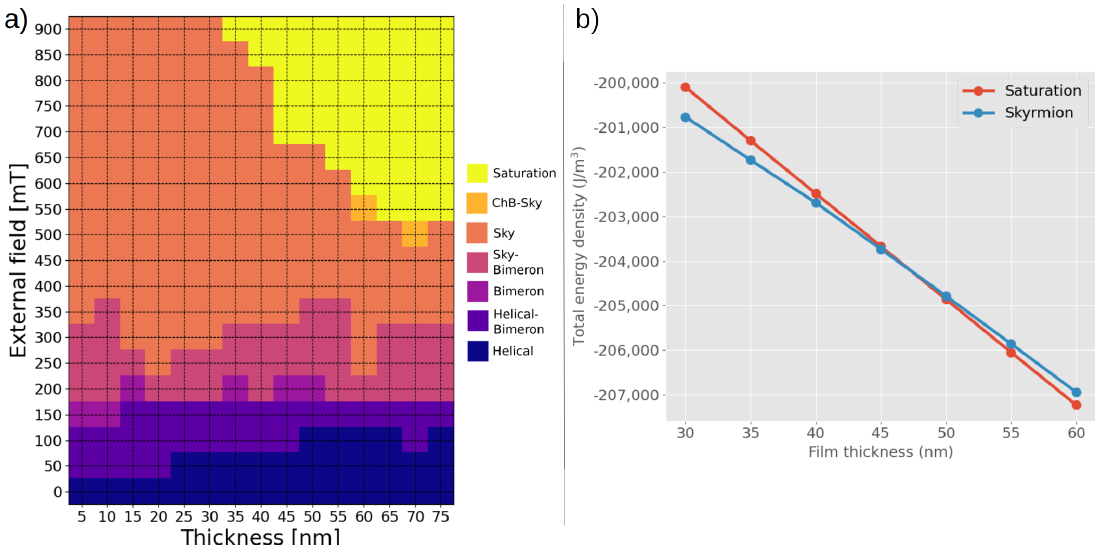
Figure 3. ( a ) Phase diagram displaying the lowest-energy magnetic configuration in the FeGe platelet as a function of the film thickness and the external field strength. At high fields and large film thickness, the quasi-saturated state is the ground state. By lowering the film thickness, the formation of skyrmion structures tends to become energetically favorable. ( b ) Energy density as a function of the film thickness in the case of the skyrmion state (blue line) and the quasi-saturated state (red line) in an external field of